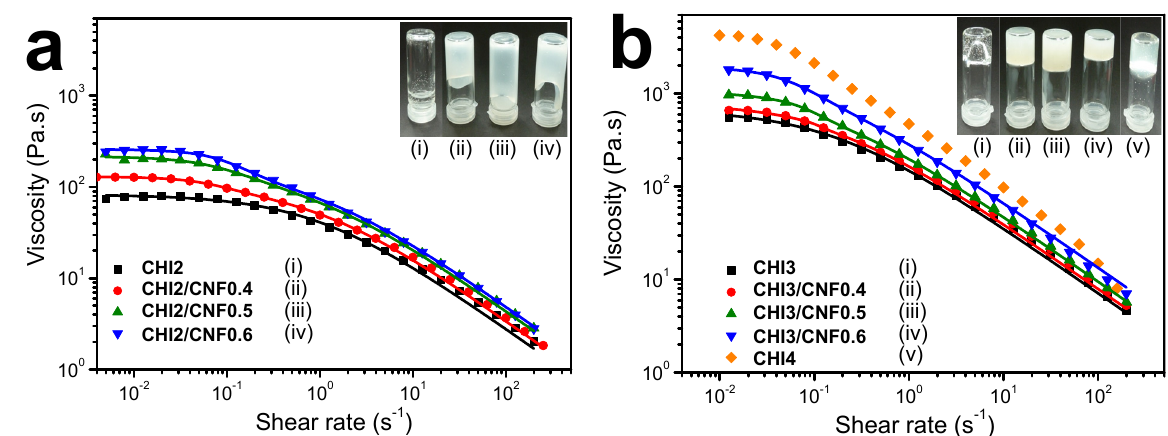
Figure 2. Flow diagrams of the CNF-filled CHI viscous inks ( a ) and the corresponding naked CHI inks ( b ). Solid lines represent the fitting of the rheological behavior with the Cross model equation (Equation (1)) for CHI solutions, and with the double Cross model equation (Equation (2)) for the CHI/CNF suspensions. Insets in show pictures of the different viscous inks.